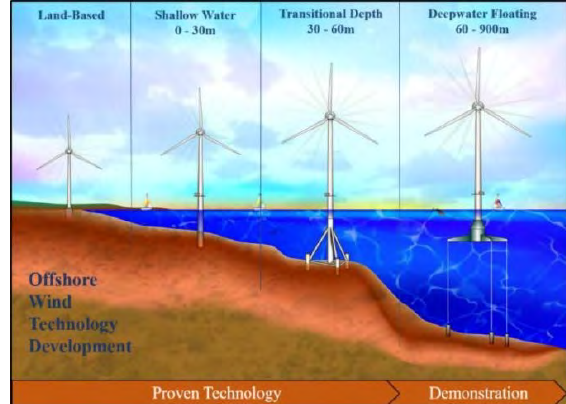
Figure 1. Figure 1 OWT water depth classification (Jonkman, & Buhl, 2005)